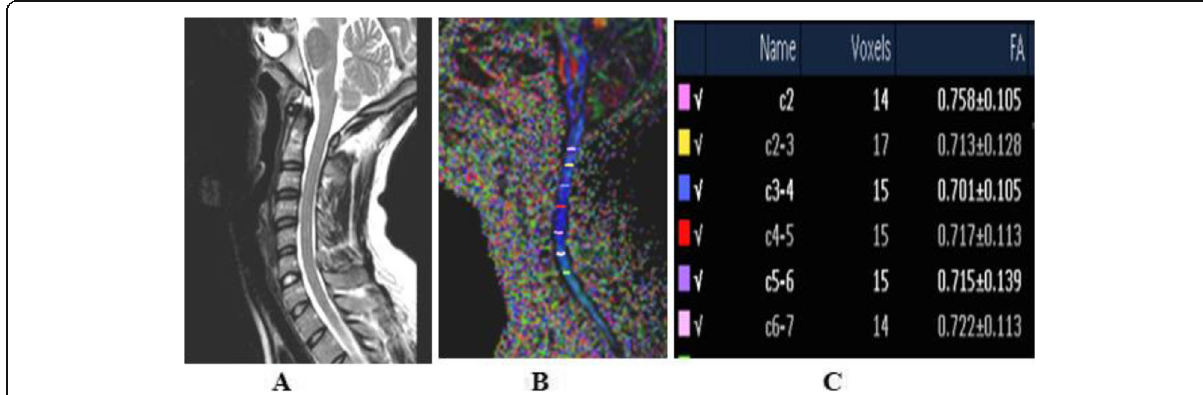
Fig. 3 Twenty-two - year-old female patient, presented with neck pain and bilateral brachialgia. a Sagittal T2 of the cervical spine showing no significant disc lesions. b Color-coded FA map of the cervical spinal cord showing no change in blue color with multiple ROIs opposite to different disc levels. c FA values opposite to all the examined cervical discs with no gross